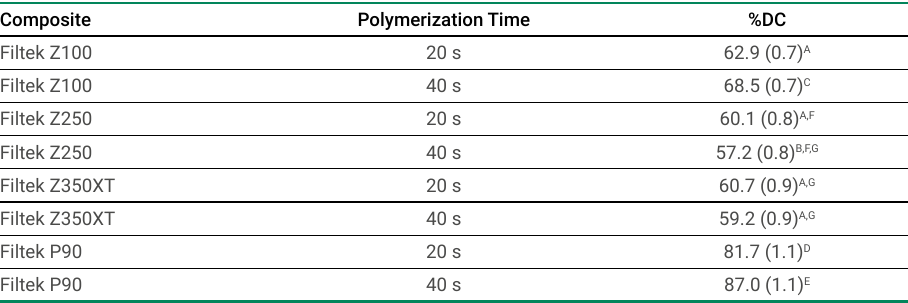
Table 2. Degree of conversion (DC) of resin composites after irradiation by 20 or 40 s (n=3). Standard deviation in parentheses. Composite Polymerization Time